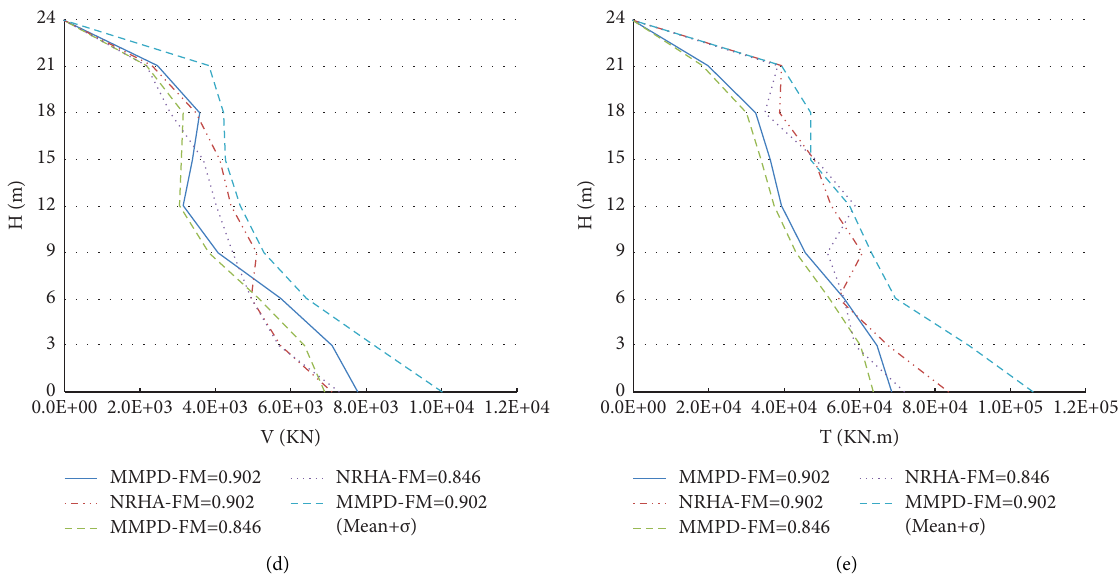
Figure 23: Building B3 under LANDERS record with diferent distributions of reinforcements: (a) comparison between NRHA and interstorey drifts limit, (b) NRHA fexural moment demands and MMPD fexural capacities of 30cm wall, (c) NRHA fexural moment demands and MMPD fexural capacities of 20cm wall, (d) NRHA/approximated MMPD shear demands, and (e) NRHA/approximated MMPD torsional demands.